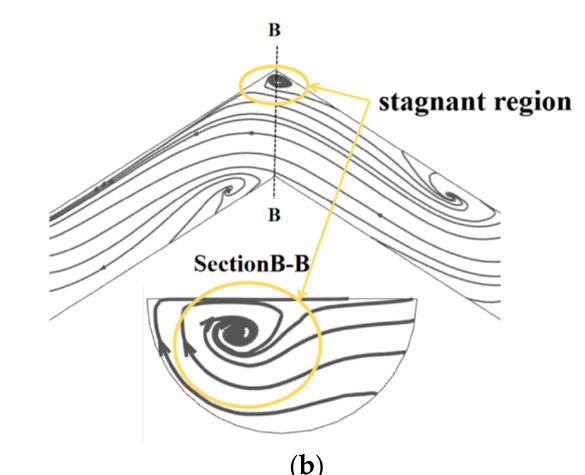
Figure 11. Turning point and stagnant region: ( a ) Turning point; ( b ) Stagnant region.